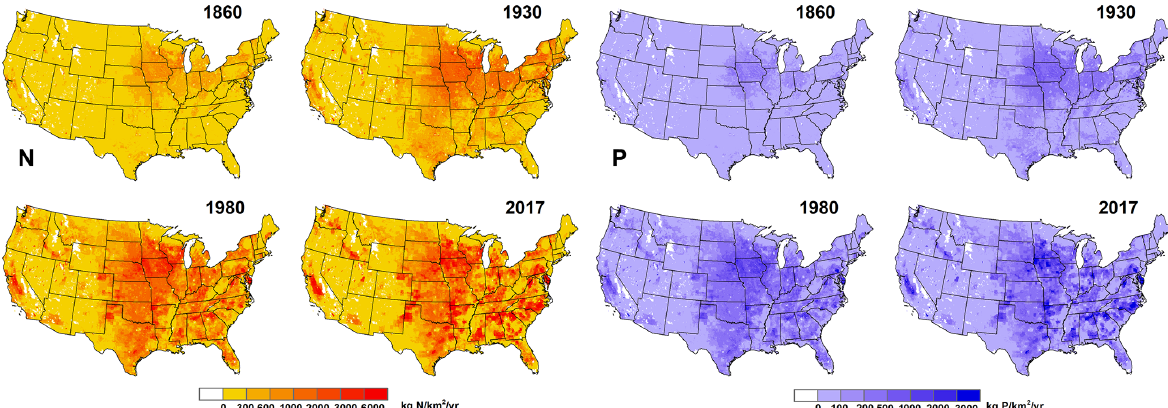
Figure 3. Spatial distribution of manure N and P production across the contiguous US in 1860, 1930, 1980, and 2017. (Note: 1930 and 2017 were the earliest and latest years of available USDA census data, respectively, and 1980 was chosen as the year in the middle of these 2 years.)